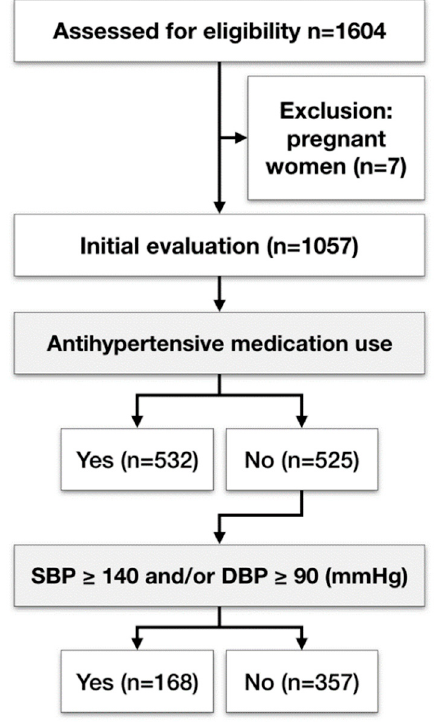
Figure 1. Flow diagram of cohort selection of patients from the Study of Periodontal Health in Almada-Seixal.